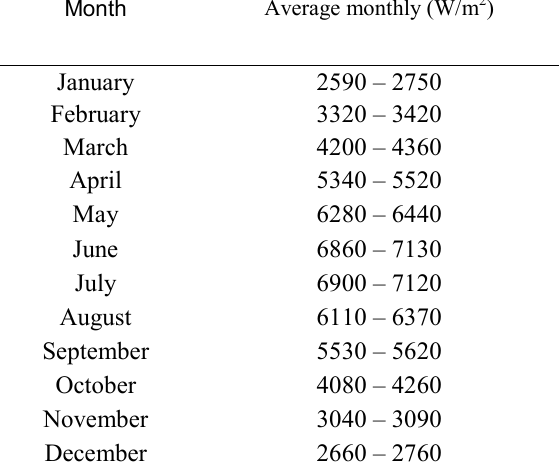
Table 1. The monthly average values of daily global solar radiation (W/m 2 ) in